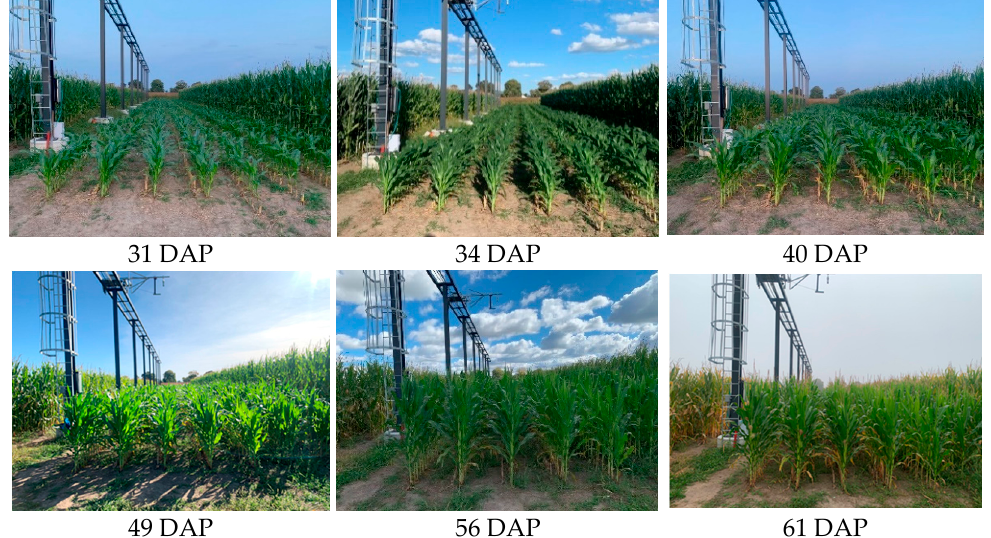
Figure 3. The growth of corn plants in the Purdue ACRE field during the experiment at different